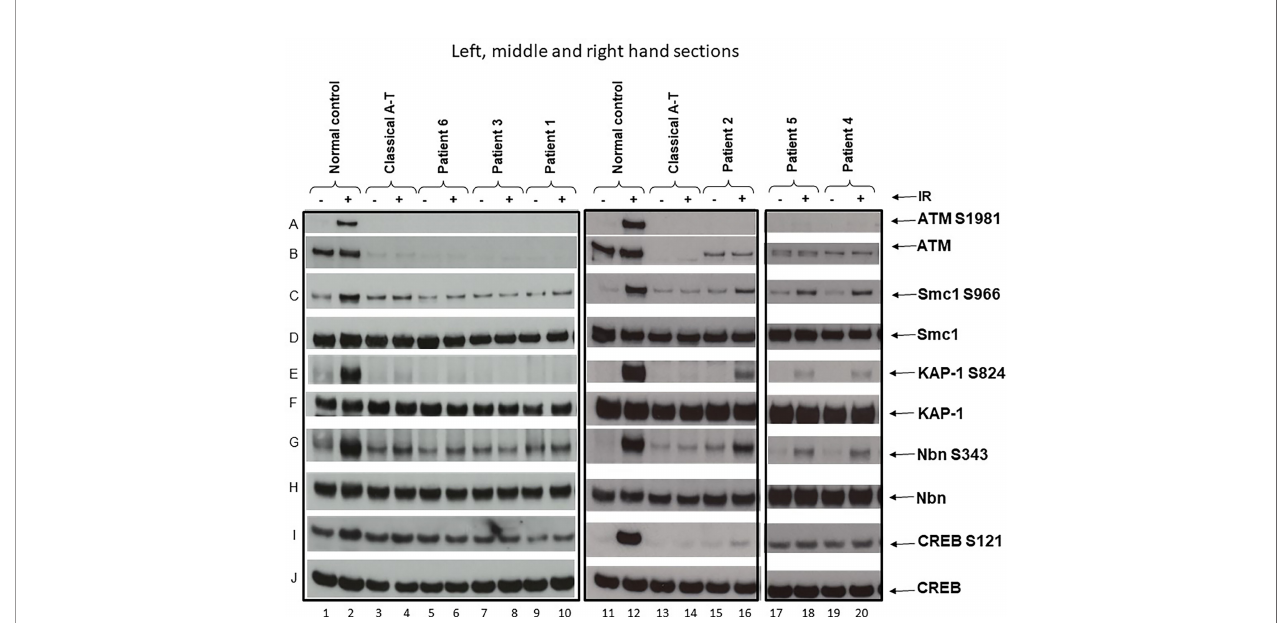
FIGURE 1 | ATM and ATM kinase activity/signalling in cells from ataxia telangiectasia patients 1 – 6. Assay showing the presence or absence of ATM in cells from each patient and whether this was associated with some activity/signalling ability. Cells were either irradiated (IR) with 2-Gy x-rays or not irradiated. The left-hand section show the results of the three classical patients, the middle section the results of variant patient 2, and the right-hand section the results of variants 4 and 5. Left-hand section, lanes 1 & 2 — positive control. (A) Cells from a normal individual showing presence of ATM protein (B) and normal ATM activity/signalling showing phosphorylation of the targets SMC1 ser966 (C) , KAP-1 ser 824 (E) , Nbn ser343 (G) , and CREB ser121 (I) . There is a strong signal for each of these in lane 2 after activation. The total levels of SMC1, KAP-1, Nbn, and CREB are also shown in (D, F, H, J) , respectively. Lanes 3 and 4 — negative control. Cell lysate from a classical A-T patient with mutations ATM, c.1355delC; p.(Thr452AsnfsTer21) and c.3802delG; p.(Val1268Ter). Both are frameshift mutations leading to instability and loss of the ATM from both alleles. There is no differential phosphorylation of these targets in this patient ’ s cells inane 4 — consistent with the patient having A-T; there is no ATM (B) . Lanes 5 and 6 show cell lysates from patient 6, lanes 7 and 8 lysates from patient 3, and lanes 9 and 10 lysates from patient 1. Just as with the negative control (lane 4), lysates from these three patients show absence of ATM protein (B) and absence of a differentially increased phosphorylation induced by irradiation, as indicated by absence of phosphorylation of SMC1 ser966, KAP-1 ser824, Nbn ser343, and CREB ser121 in lanes 6, 8, and 10, respectively. Middle section: lanes 11 and 12 show lysates from the same normal control as in lanes 1 and 2. Lanes 13 and 14 are cell lysates from the same classical A-T patient as in lanes 3 and 4. Lanes 15 and 16 are lysates from variant patient 2. (B) con fi rms that the lysate shows a low level of ATM protein. In contrast with the negative control (lane 14), this lysate shows a clear low level of ATM kinase activity/signalling as indicated by the presence of some moderate phosphorylation of SMC1 ser966, KAP- 1 ser824, Nbn ser343, or CREB ser121 in lane 16. Right-hand section, lanes 17 and 18 and 19 and 20 are lysates from variant patients 4 and 5. The positive and negative controls have been removed but were the same as in lanes 1 – 4 and 11 – 14. (B) con fi rms that the variant lysates show a low level of ATM protein. In contrast to the negative controls in lanes 4 and 14, these lysates also show a clear low level of ATM that has some retained kinase activity/signalling as indicated by the presence of moderate phosphorylation of SMC1 ser966, KAP-1 ser824, and Nbn ser343 in